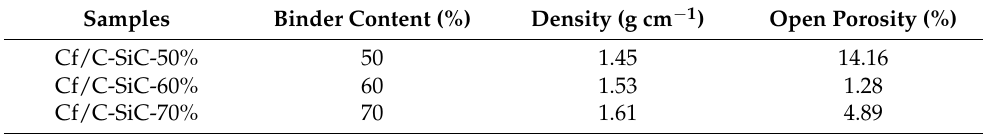
Table 2. Density and porosity of Cf/C-SiC composites with different binary binder